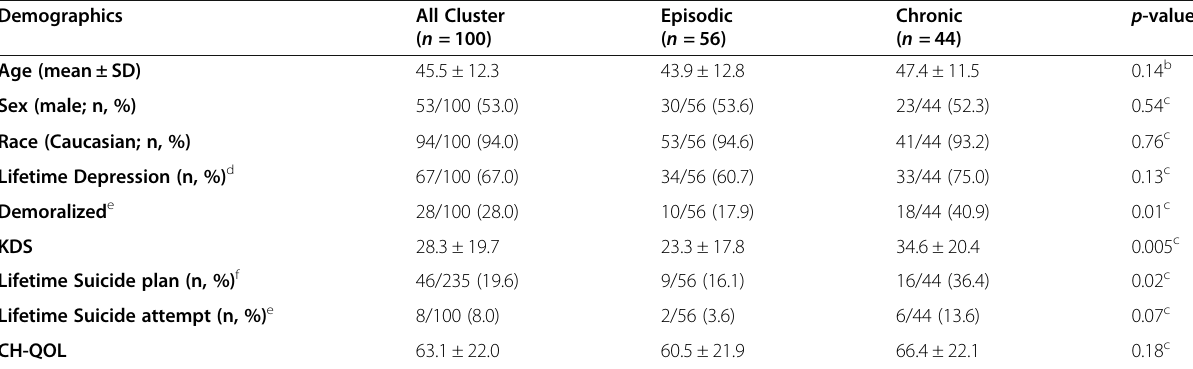
Table 4 Demographics and Mental Health in Cluster Headache Patients